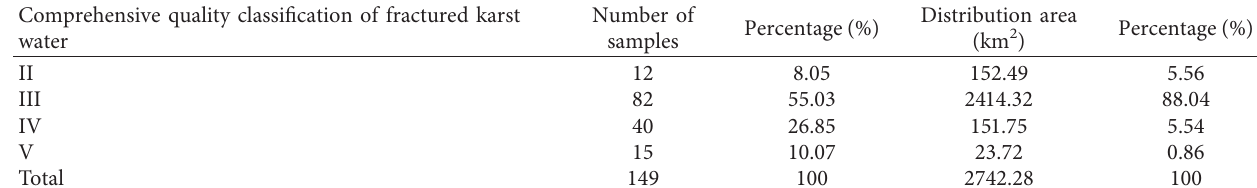
Table 9: Comprehensive quality evaluation of fractured karst water.